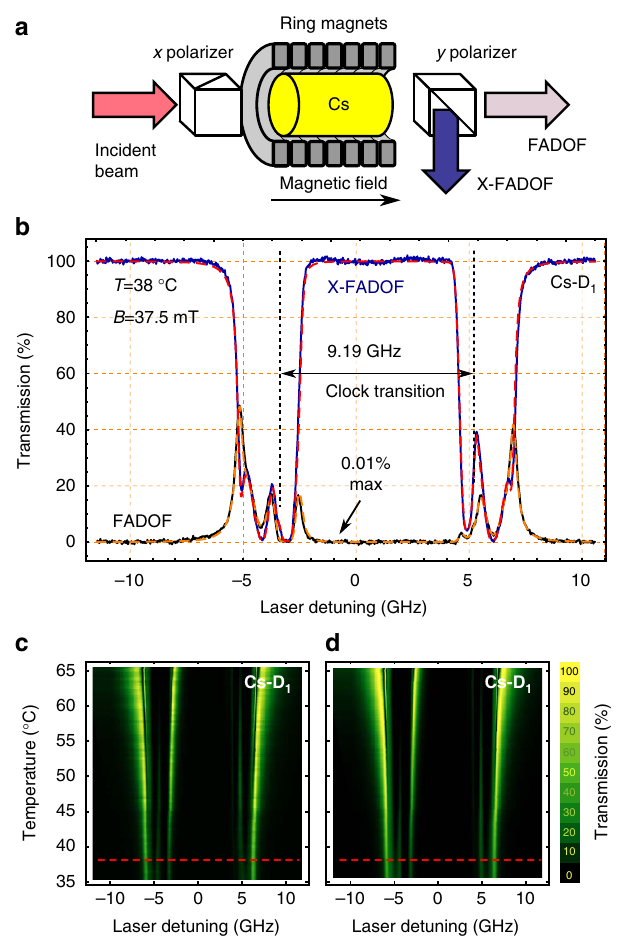
Figure 1 | Experimental and theoretical characterization of the Faraday filter. ( a ) Experimental setup. The caesium vapour cell is placed between two crossed polarizers. A magnetic field is applied via ring shaped permanent magnets. The incident laser is polarized by the first x polarizer and then analysed in cross-polarized configuration after passing through the FADOF. ( b ) Transmission spectra of the Cs-D 1 line plotted as function of the laser detuning for the FADOFand X-FADOF. Laser detuning refers to the angular frequency against the transition frequency of atomic caesium (2 p (cid:2) 335.116048807(41) THz, centre wavelength l vac ¼ 894.593nm). Transmission (FADOF, calculated: orange, dashed; measured: black) and the second output port (X-FADOF, calculated: red, dashed; measured: blue). When both spectra are added, the Doppler spectrum is obtained. ( c ) Measured transmission spectrum as a function of temperature and laser detuning, red dashed line indicates data shown in ( b ). ( d ) Fit of the measured transmission data shown in ( c ). All fits and calculations are performed according to ref.